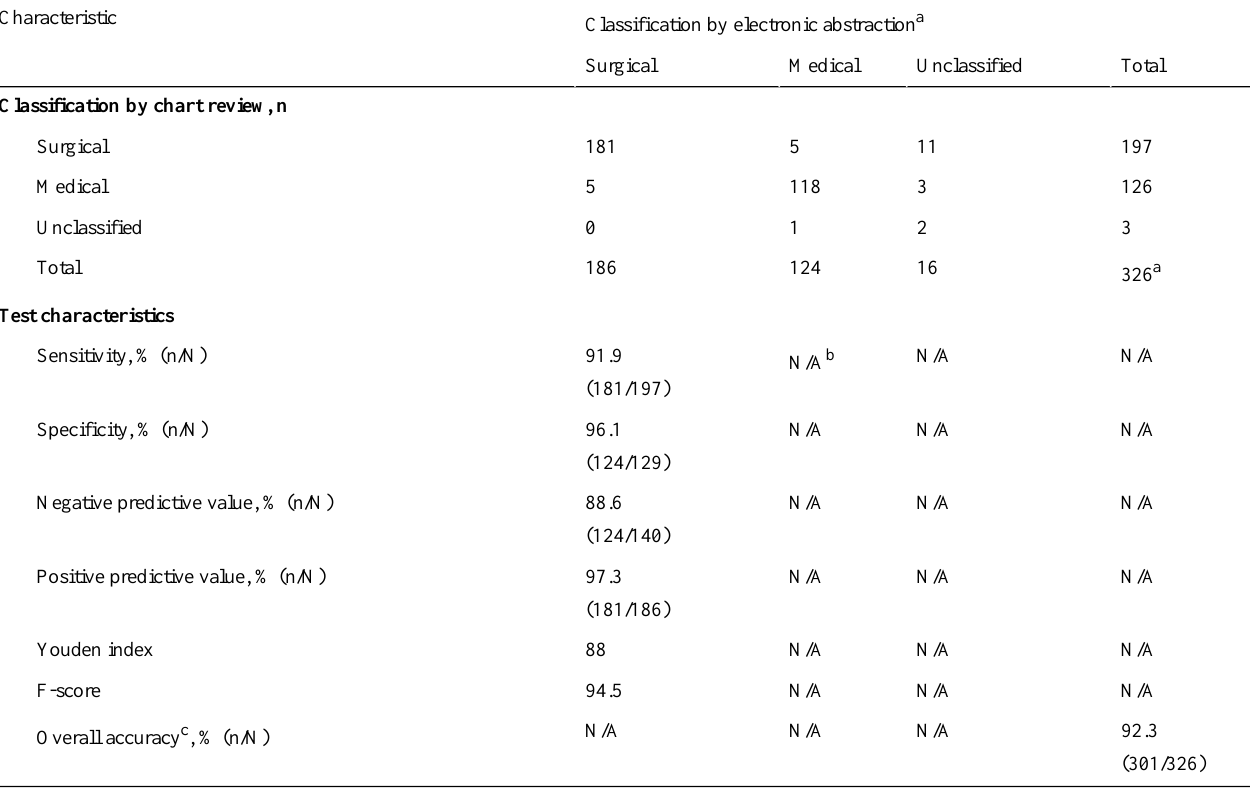
Table 3. Ectopic pregnancy management ascertainment performance of electronic data abstraction.